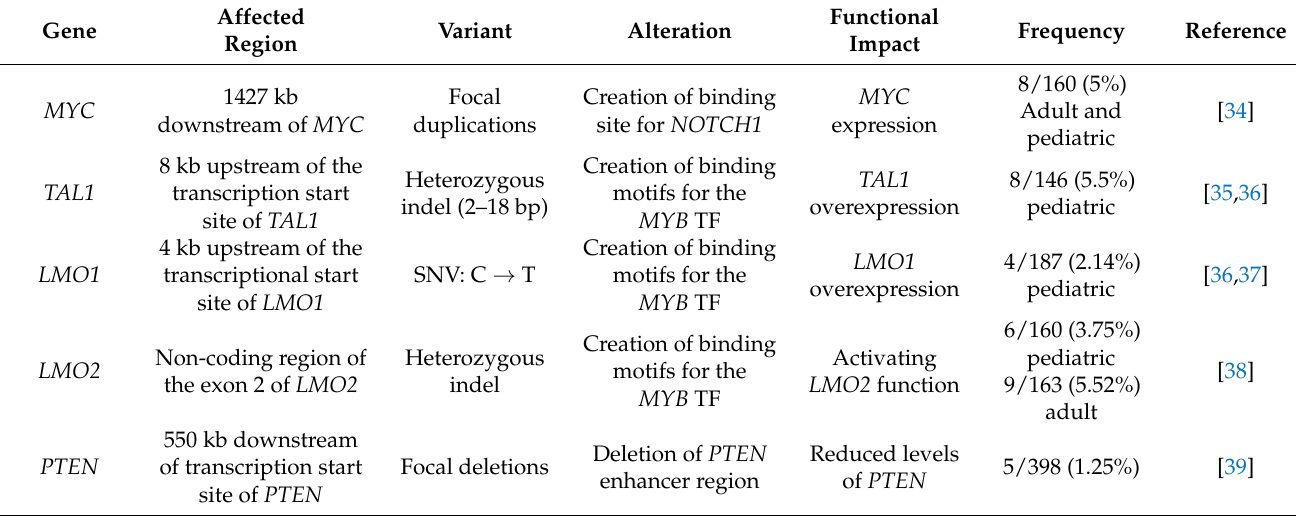
Table 1. Non-coding mutations identified so far in